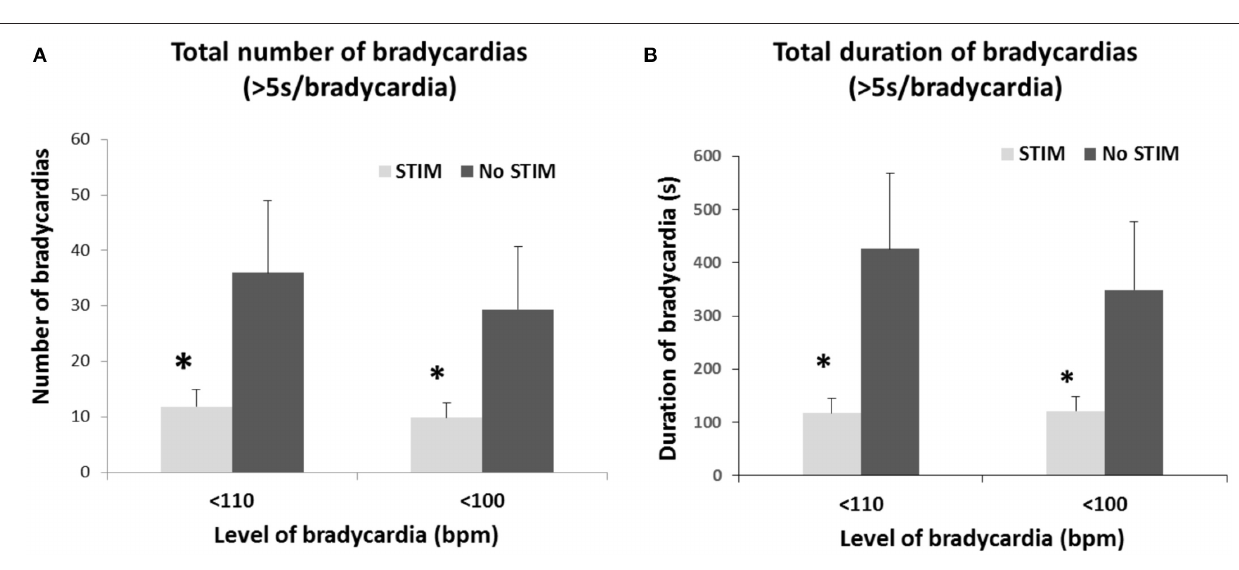
FIGURE 5 | Limb proprioceptive stimulation in premature infants reduced the total number (A) and the total duration (B) of mild ( < 110 bpm) and moderate ( < 100 bpm) bradycardic episodes from pre-stimulation periods. A 3-fold reduction in total duration of both mild and moderate bradycardia episodes occurred. * p < 0.05. From